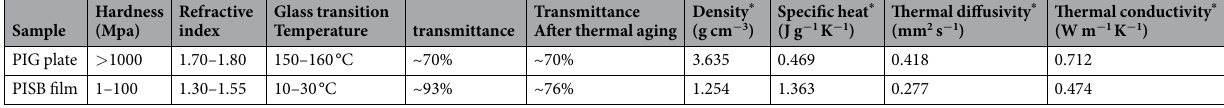
Table 2. Mechanical and thermal properties of the PIG plate and PISB film samples. * Average value for three times